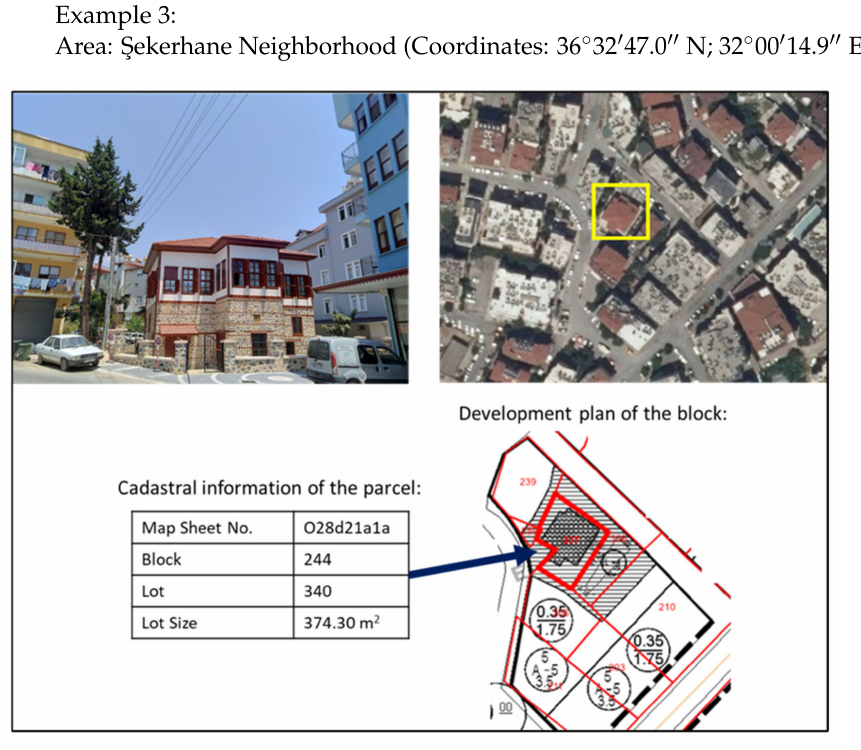
Figure 5. The third example of historic buildings. Private residence (photographed in July 2019). The historic building is located on the parcel No. 244/340 and the size of the parcel is 374.30 m 2 . The current building’s total floor area is around 525 m 2 . The FAR value for the block is “1.75” in the development plan (Figure 5). If there was no restriction, the lot would have 374.30 m 2 × 1.75 ≈ 655 m 2 total floor area potential. The restricted floor area of the landowner is approximately 655 m 2 − 525 m 2 = 130 m 2 . The market value of a m 2 in the area is accepted as 5000 TL/m 2 like in the previous examples. The total market value of the unused floor area would be 130 m 2 × 5000 TL = 650,000 TL. The construction cost of the unusable floor area would be 188,500 TL (130 m 2 × 1450 TL/m 2 ). If we subtract it from the market value of the unused floor area, 650,000 TL − 188,500 = 461,500 TL (~$60,485; USD/TL: 7.63) is the total economic loss of the owner of the preserved building (Table 3). More examples can also be given; however, the above examples are sufficient to understand the overall